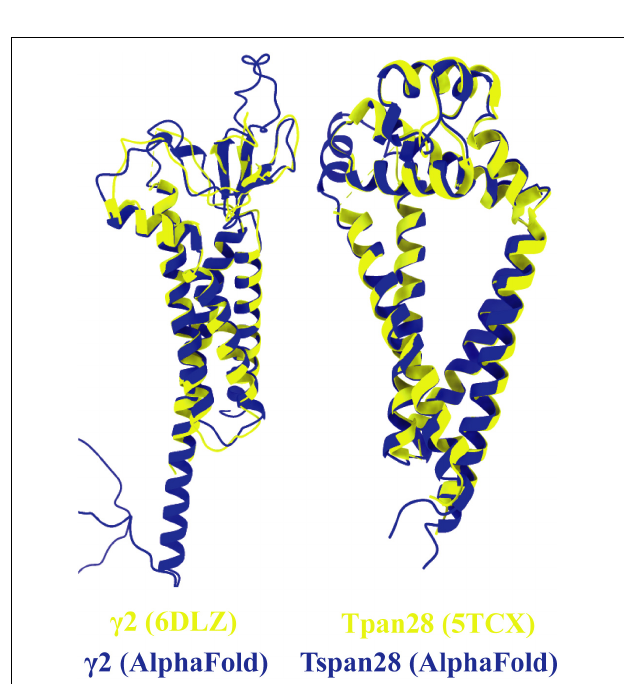
FIGURE 8 | Overlays of predicted and resolved structures. To obtain an impression of the accuracy and reliability of the structures predicted by AlphaFold, the corresponding pdb files of the solved structures of γ 2 [(left) pdb model 6DLZ, colored in yellow] and Tspan28 [(right) pdb model 5TCX, colored in yellow] were superimposed on the respective AlphaFold predictions (colored in